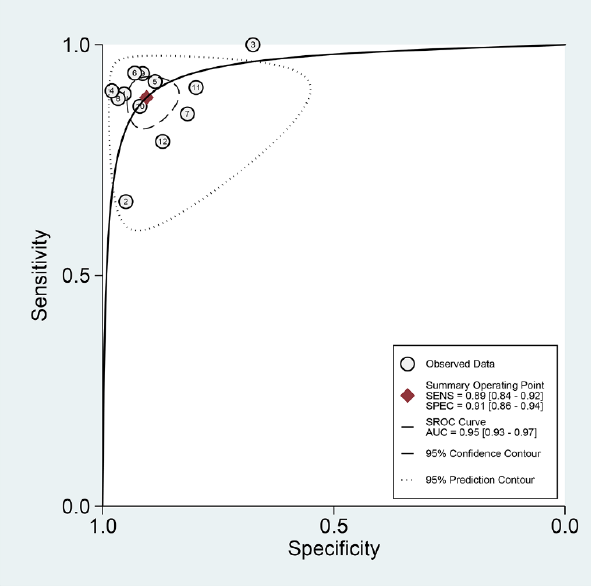
Figure 4. Summary receiver operating characteristic curve with 95% confidence region and prediction region of computer-aided diagnosis models for the diagnosis of gastrointestinal protruded lesions in wireless capsule endoscopy images.